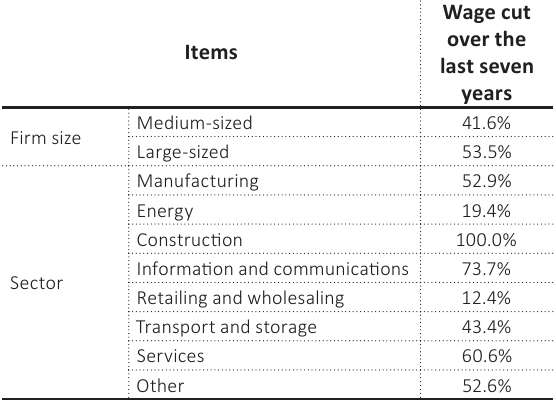
Source: Own research.